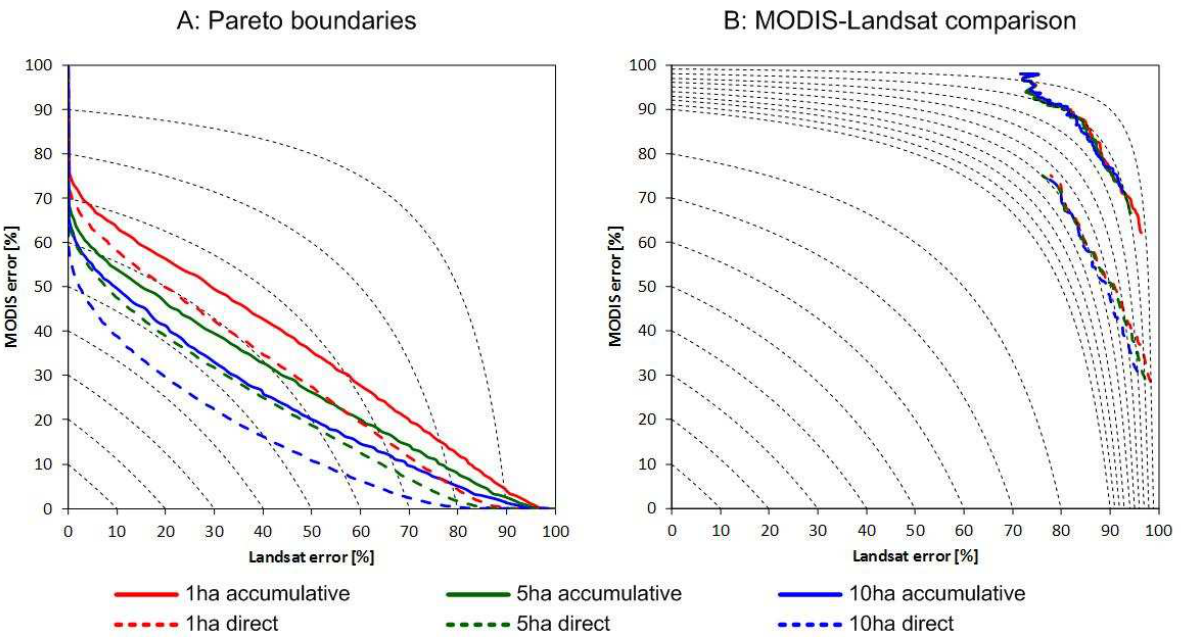
Figure 4. MODIS-Landsat error plots for Pareto boundaries (A) as best achievable result and Landsat-MODIS data comparison (B) using direct and aggregated annual change between 2005 and 2010 from MODIS potential changes and Landsat change with 1ha, 5ha and 10ha MMU.